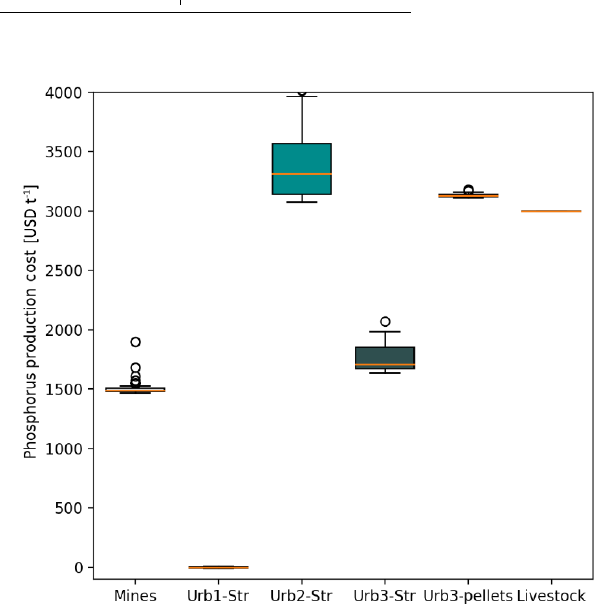
Figure 3. Minimum calculated production costs per tonne of re- cycled P for supply nodes. Urb1-Str shows the prices for struvite from WWTP in countries with highly developed sanitation sys- tems (BNR), where the struvite is offered for free (excluding trans- port costs) because of the maintenance and sludge handling savings by controlled struvite precipitation, Urb2-Str is from nations with slightly less developed sanitation systems, Urb3-Str shows source- separated urine collection and struvite precipitation in nations with underdeveloped sanitation systems, Urb3-Pellets is the price per tonne of P (0.1%) in urban compost pellets, and Livestock shows the price per tonne of P in livestock pellets